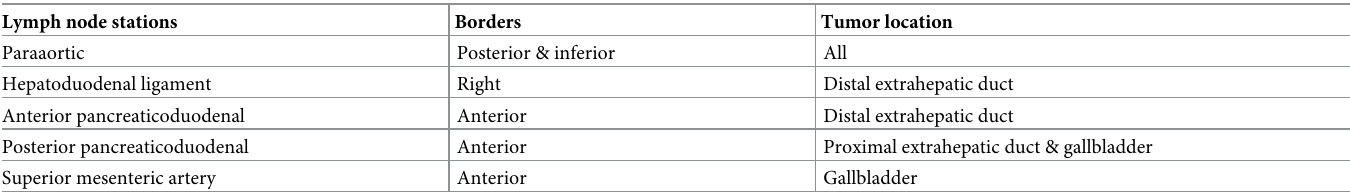
Table 3. Regional lymph nodes station and borders showing a relatively wider